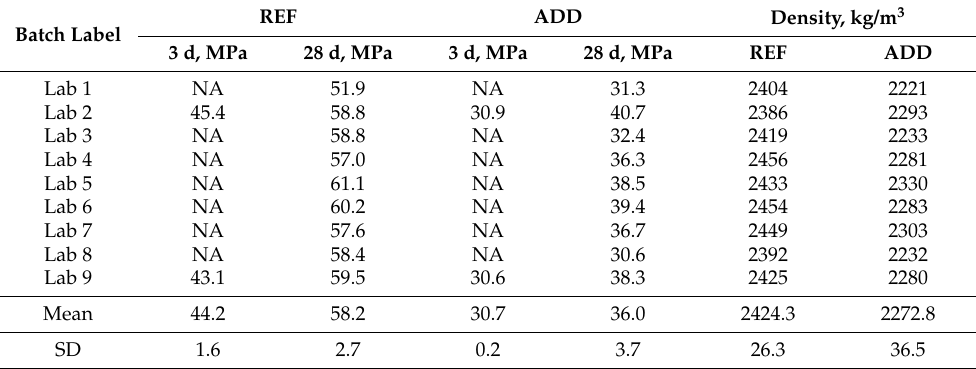
Table 5. Hardened properties (hardened density and compressive strength) at 28 days of concrete batches (SD = standard deviation, NA = not available). Indicative strength at 3 days reported for two